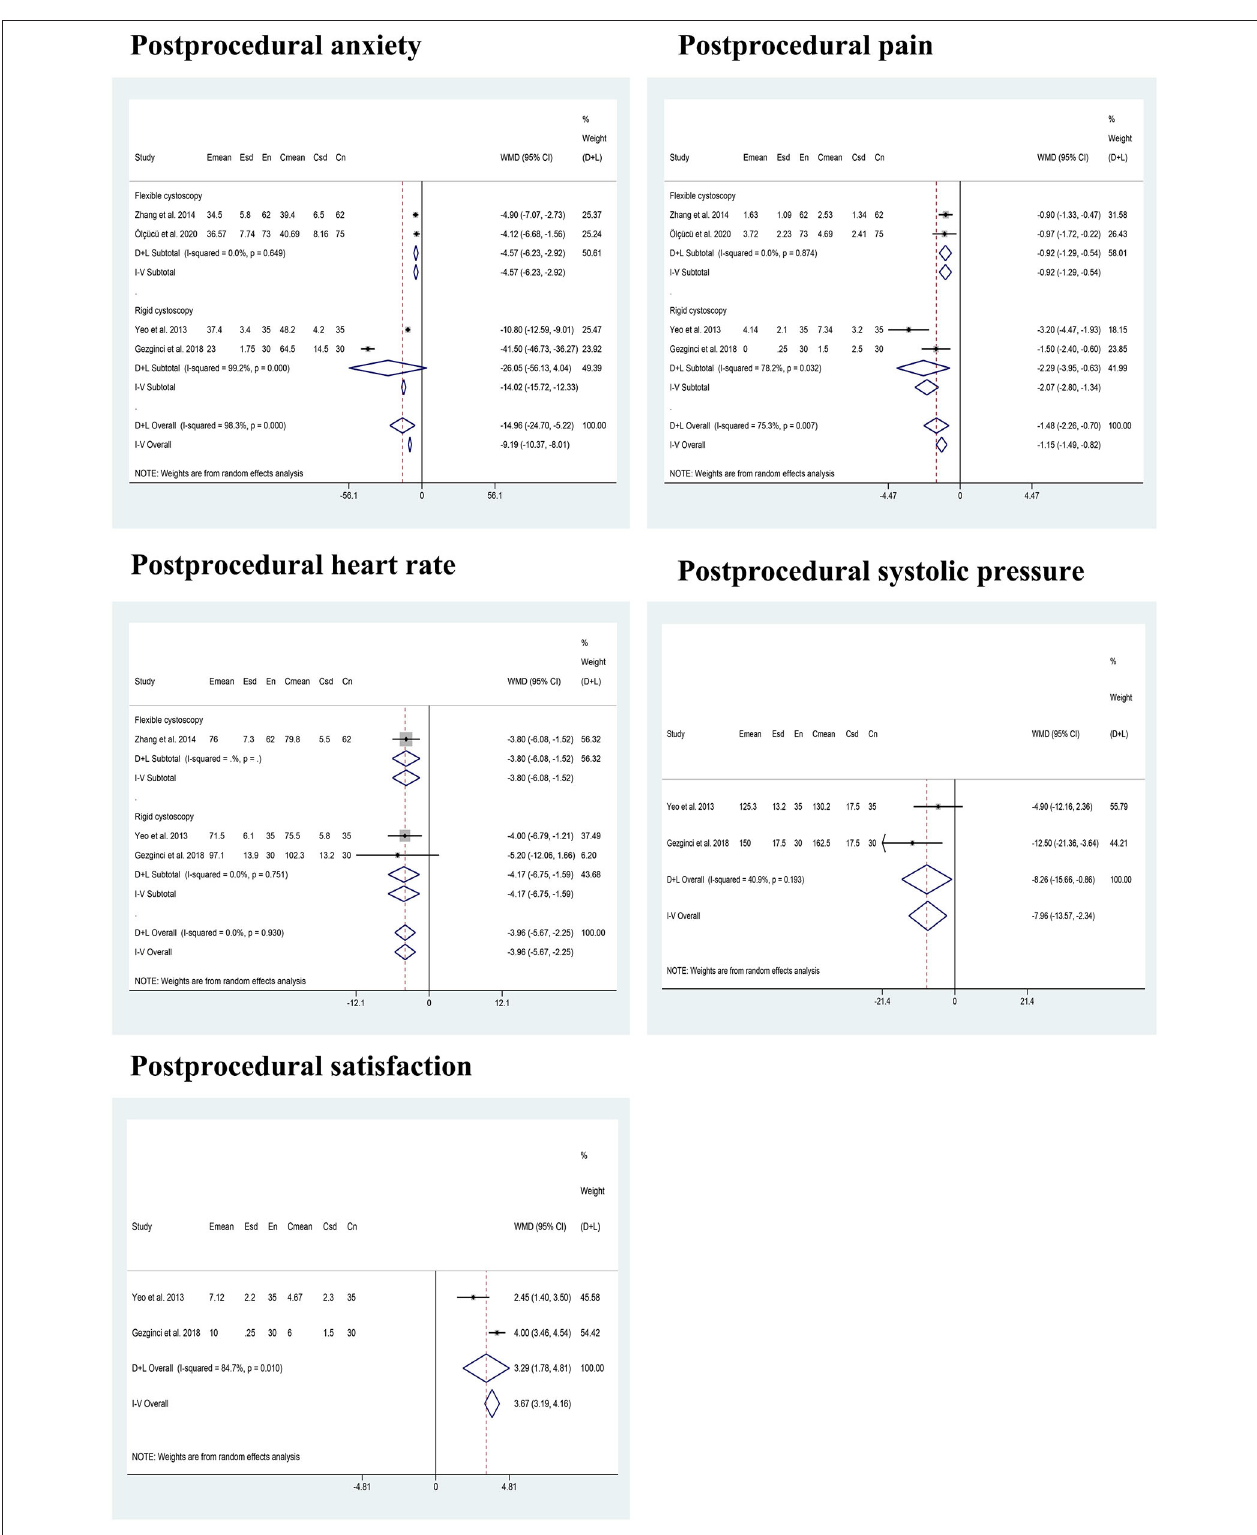
FIGURE 4 | The results of the subgroup analysis in this study.